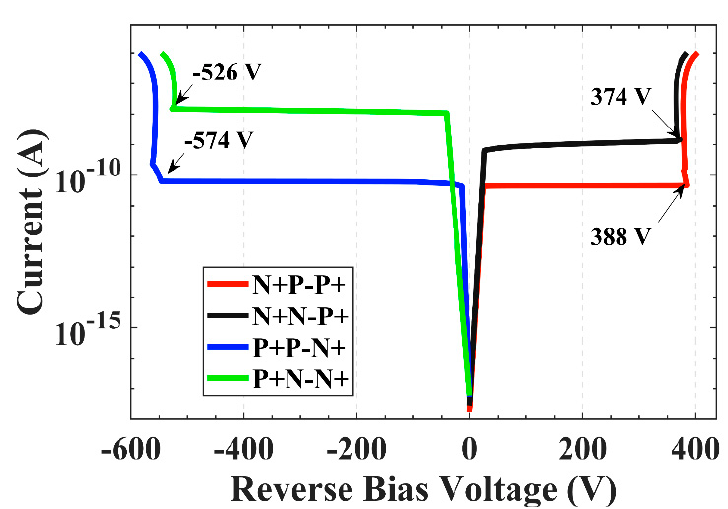
Figure 3. I–V curves of four doping types.